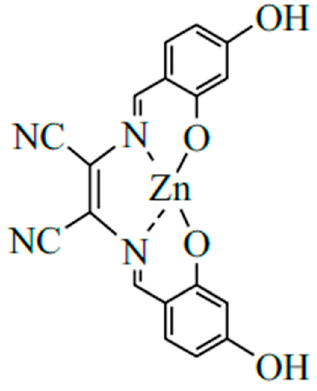
Figure 5. Structure of a model complex.